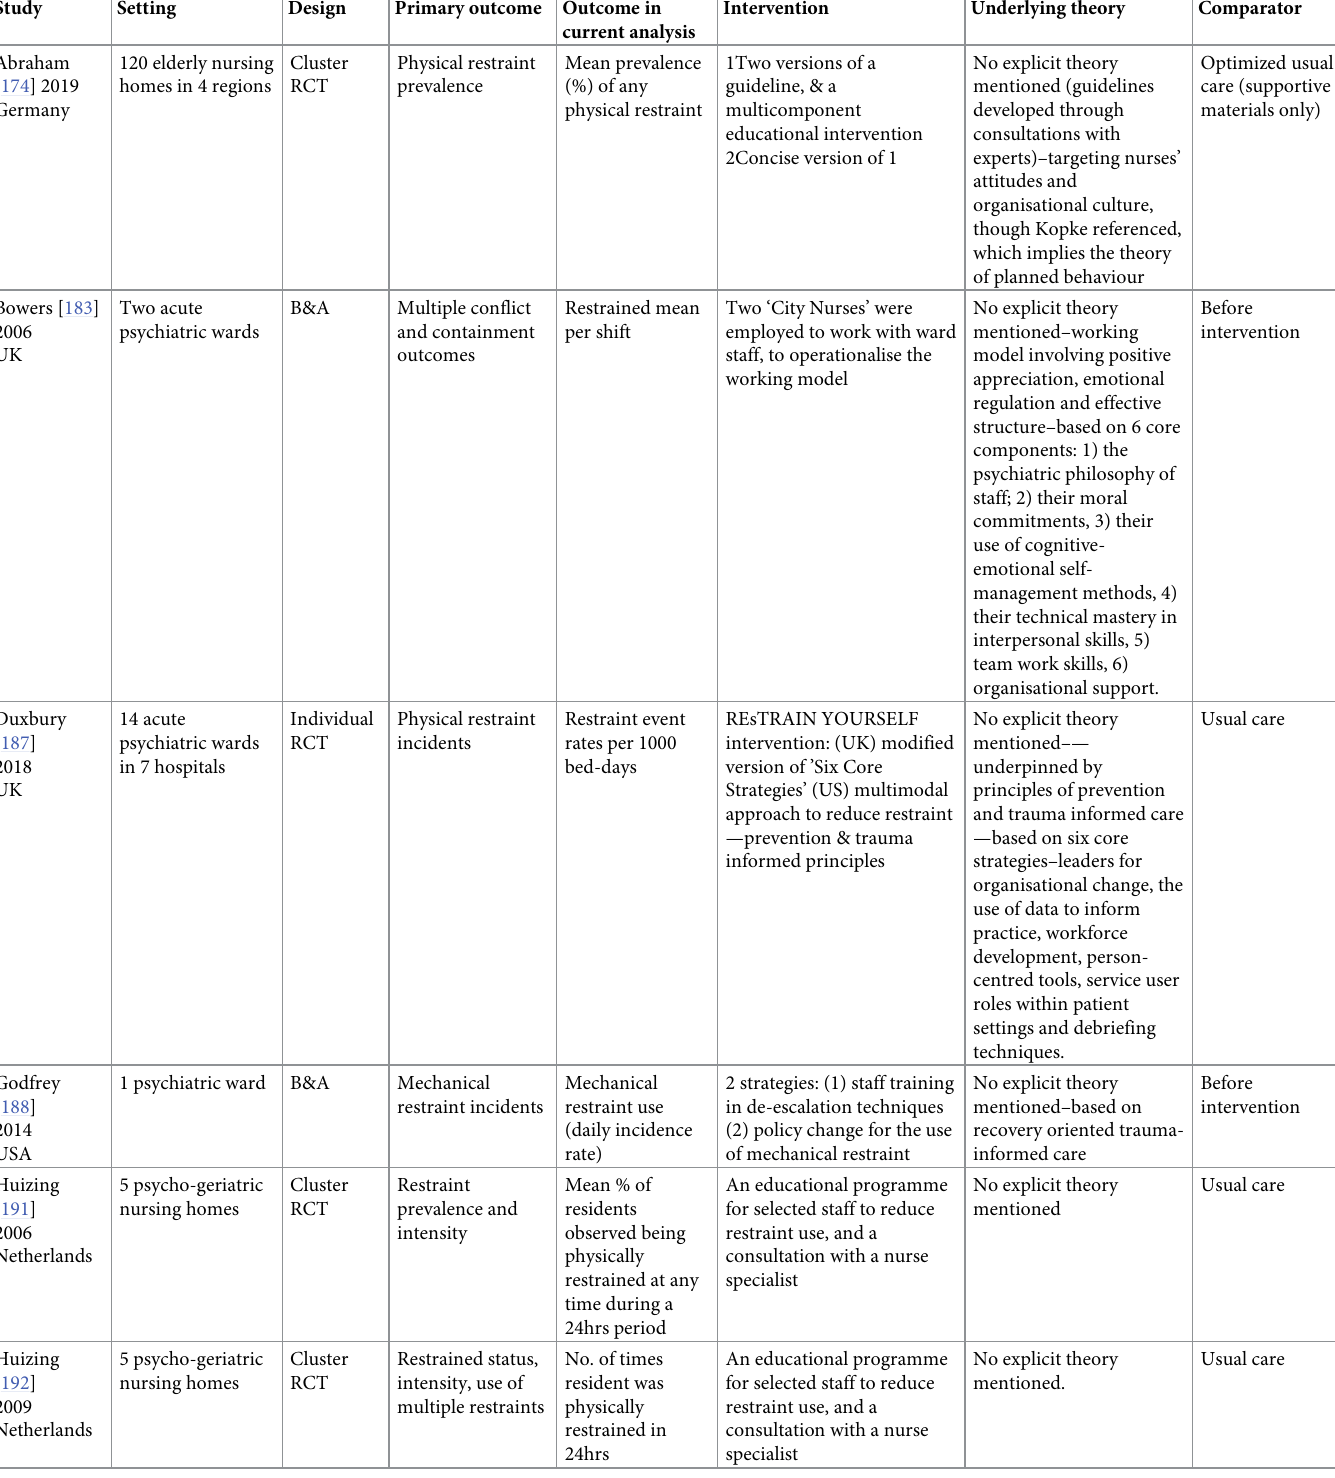
Table 4. Characteristics of studies included in the